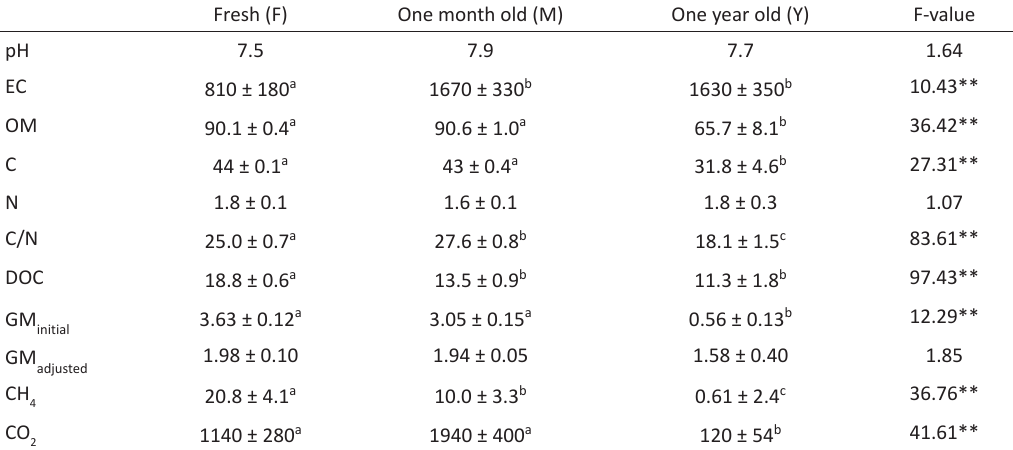
Table 1. Sample properties (average ± standard deviation) measured from four replicate dung samples. EC = electrical conductivity (µS cm -1 ), OM = organic matter concentration (% of dw), C = total carbon concentration (% of dw), N = total nitrogen concentration (% of dw), C/N = carbon to nitrogen ratio, DOC = water extractable dissolved organic carbon (mg g dw -1 ), GM = initial and adjusted gravimetric moisture (g H h -1 ) and CO = carbon dioxide production rate (mg g dw -1 h -1 ) measured at initial moisture. 2